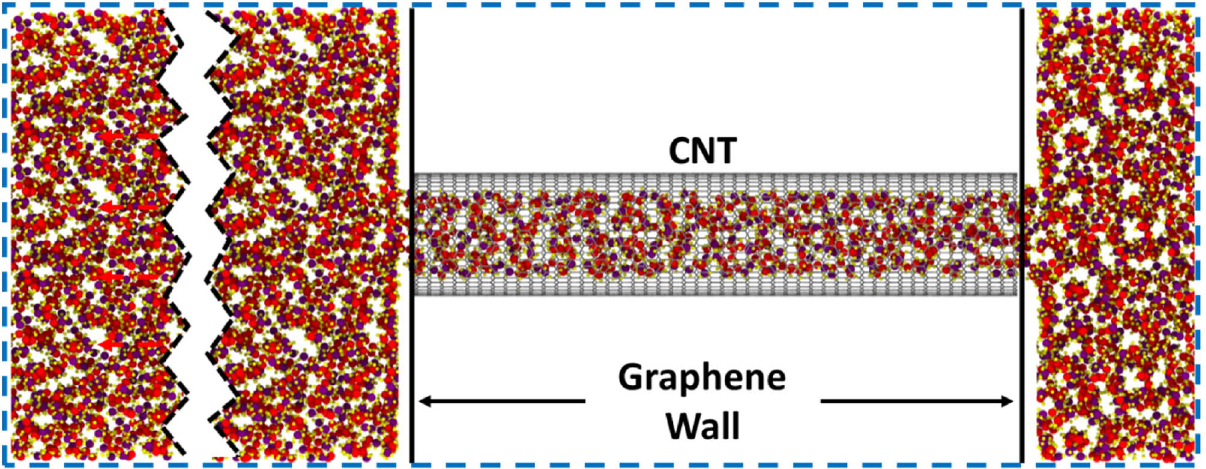
Figure 7. Setup to fill the CNT with Hexane by attaching it to a large reservoir and allow it to equilibrate. The Zig-zag line represents the kink to show the big reservoir. The blue dashed line represents the periodic boundary. Created using OVITO